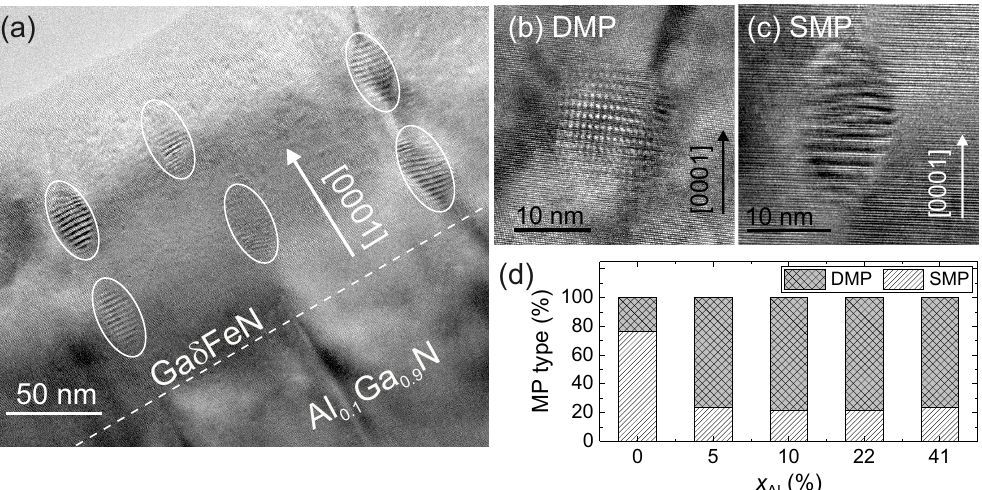
Figure 5. ( a ) Cross-section HRTEM image showing the distribution in pairs of prolate NCs along dislocations in the Ga δ FeN/Al 0.1 Ga 0.9 N sample. ( b , c ) HRTEM images of nanocrystals with double and single Moiré-patterns, respectively. ( d ) Fraction of NCs displaying SMP and DMP as a function of x Al